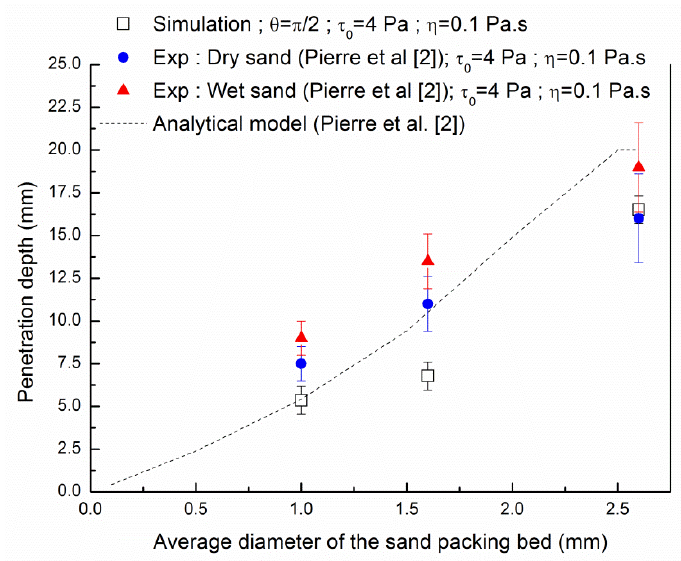
Figure 12. Comparison of the numerical penetration depth of cement paste ( 𝜏 0,𝑒𝑥𝑝 = 4 Pa; 𝜂 𝑒𝑥𝑝 = 0.1 Pa · s) and the experimental results and analytical model from Pierre et al.[27].